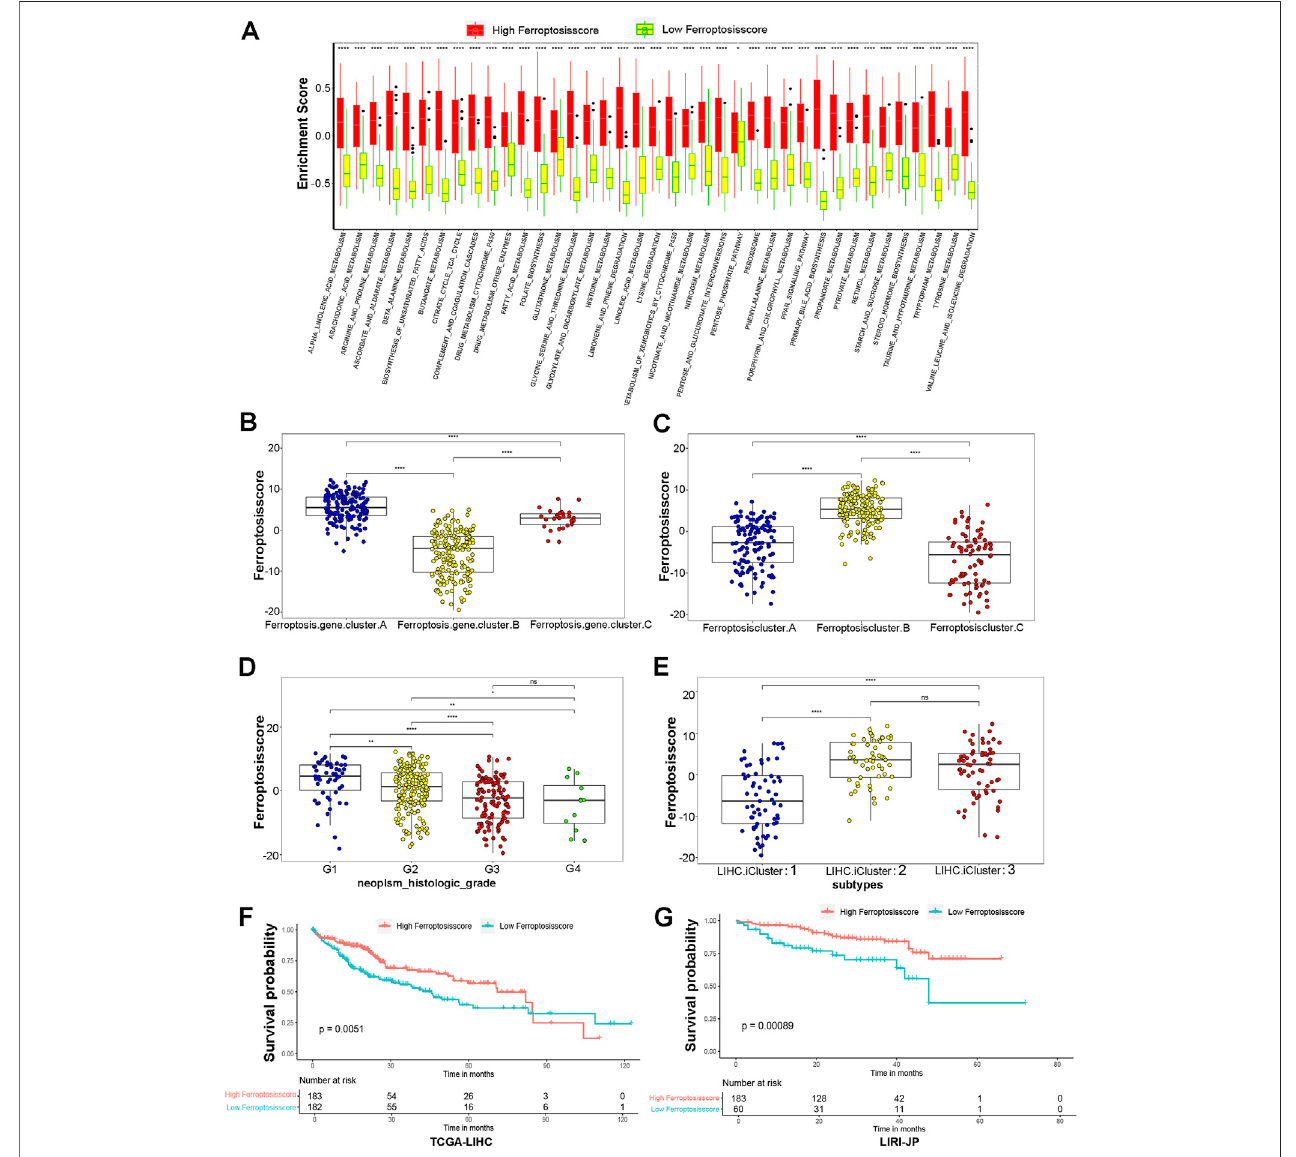
FIGURE 5 | Characteristics of ferroptosisSig score and exploration of its clinical features. (A) GSVA enrichment pathways in two ferroptosisSig score subgroups using variance analysis. (B – E) Distribution of ferroptosisscore in distinct groups: (B) ferroptosis gene clusters, (C) ferroptosis clusters, (D) tumor histologic grade, (E) TCGA-LIHC molecular subtypes byWilcoxtest. The asterisks represented thestatistical p value (* p < 0.05; ** p < 0.01; *** p < 0.001). (F – G) Kaplan-Meiercurves forhigh and low ferroptosisSig score groups in HCC patients. (F) TCGA-LIHC cohort, Log-rank test, p = 0.0051. (G) LIRI-JP cohort, Log-rank test, p = 0.00089.